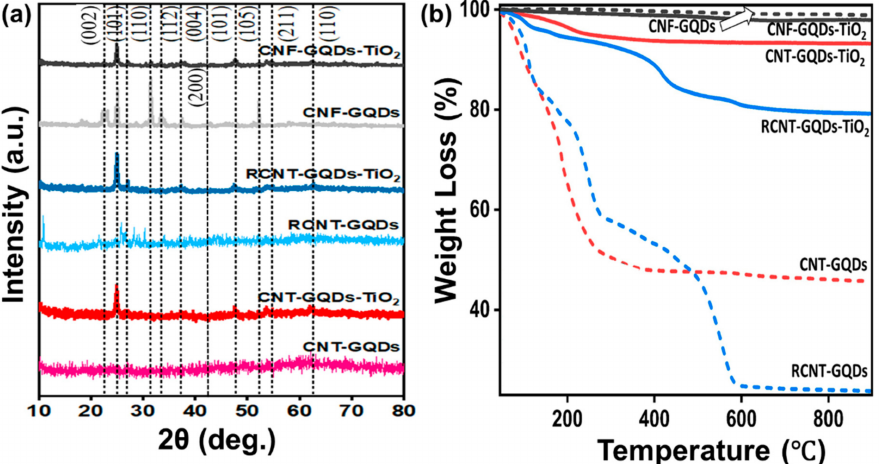
Figure 2. ( a ) XRD pattern of as-synthesized GQDs and their respective GQDs-TiO 2 nanocomposites. ( b ) TGA analysis of as-synthesized GQDs and their respective GQDs-TiO 2